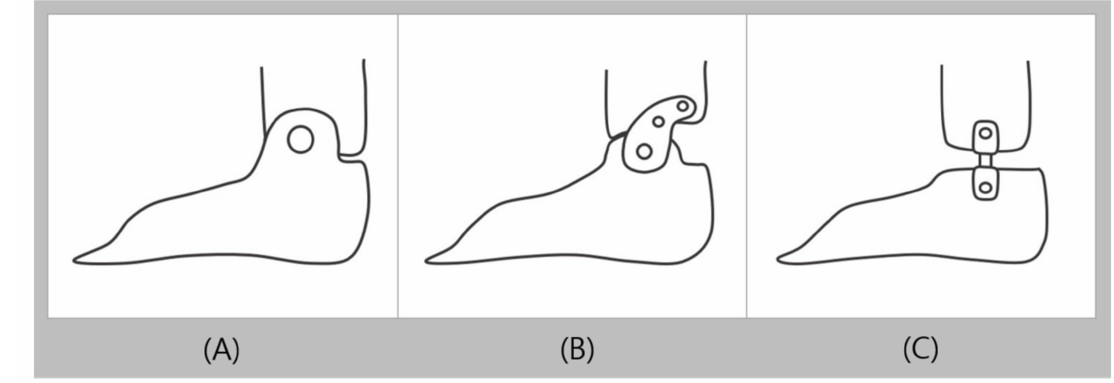
Figure 2. Commonly used types of plastic ankle foot joints ( A ): overlap joint, ( B ): Oklahoma joint, and ( C ): Gillette